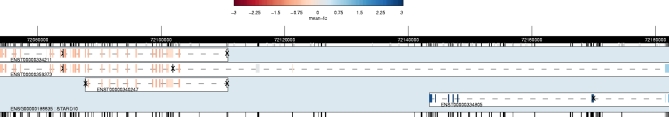
Expression for STARD10, Mapped to Known Isoforms and Coloured According to Fold Change between MCF7 and MCF10A